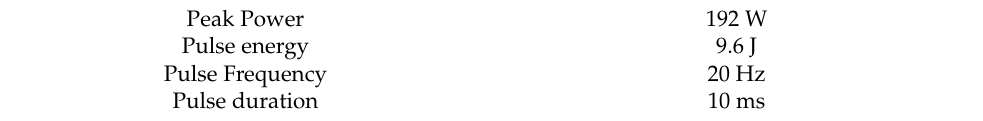
Table 4. Fixed system parameter used for calculating overlapping